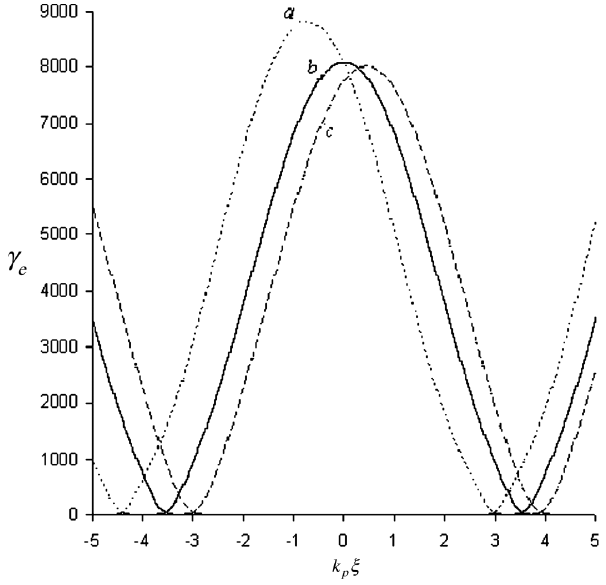
FIG. 7. Separatrix plots for the test electron with (cid:1) ¼ (cid:4) 1 (curve a ), (cid:1) ¼ 0 (curve b ), and (cid:1) ¼ þ 1 (curve c ), with injec- tion energies, respectively, as 22.5, 23.78, and 25.69 MeV, for a 0 ¼ 1 : 0 .